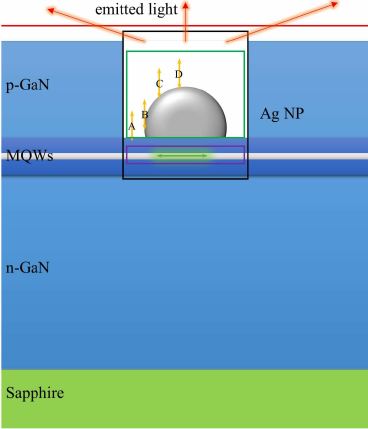
Figure 4. The schematic structure of the Ag–PhC sample in 3D finite difference time domain (FDTD) simulation. The purple, green, and black boxes were used to collect the total power radiated by the dipole, the dissipation power in the Ag NP, and the scatted energy, respectively. The red line (plane) was used to record the radiated power from top